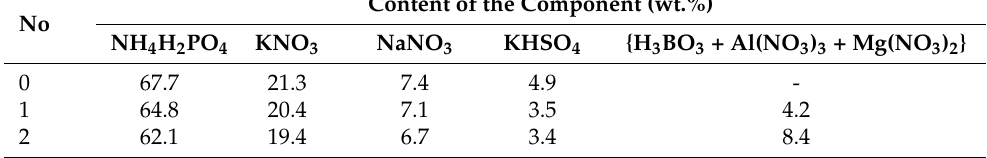
Table 1. Raw material mixtures used in the experiments. The contents of Al and Mg nitrates are indicated, excluding the H 2 O contained in their hydrates. The mixture 0 is a batch composition of the parent glass. Content of the Component